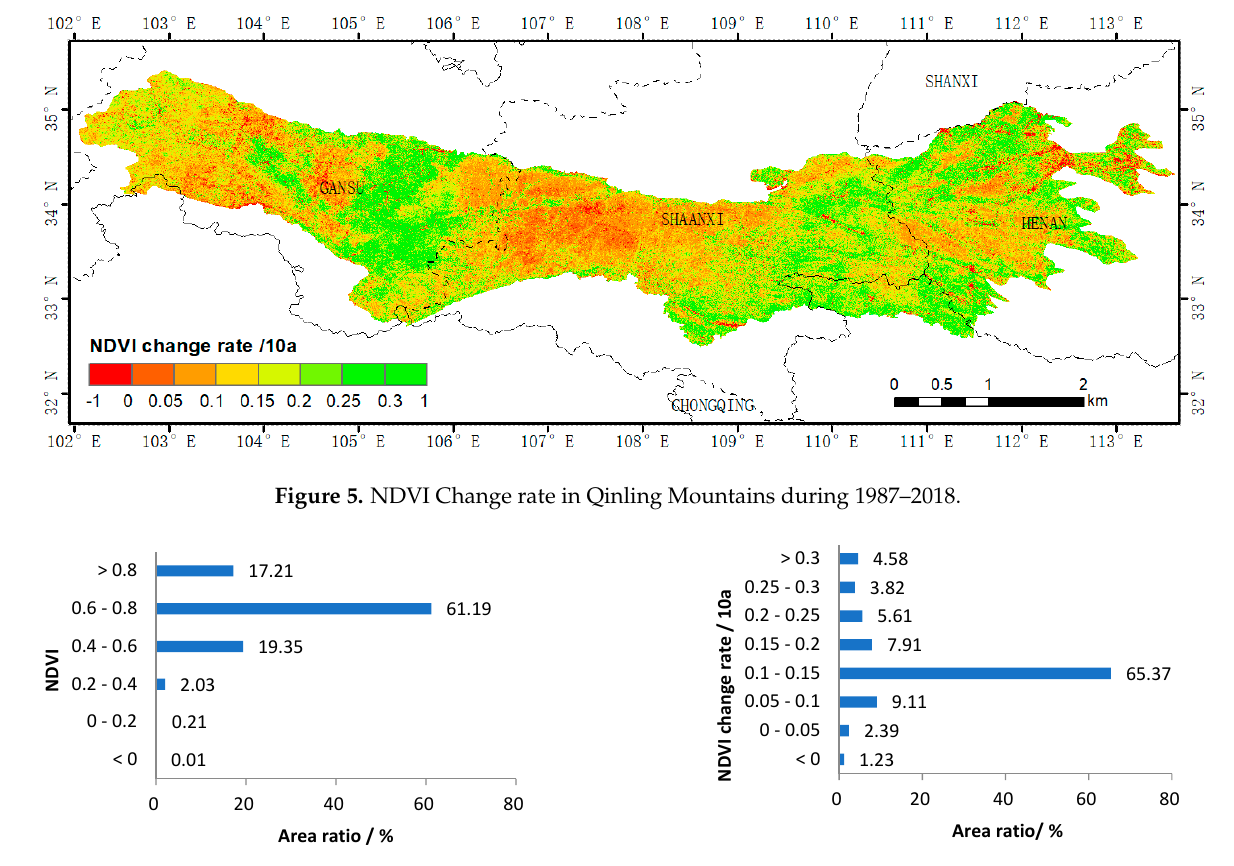
Figure 6. The area ratio of NDVI ( a ) and NDVI changing trend ( b ) in Qin Mountains during 1987–2019.